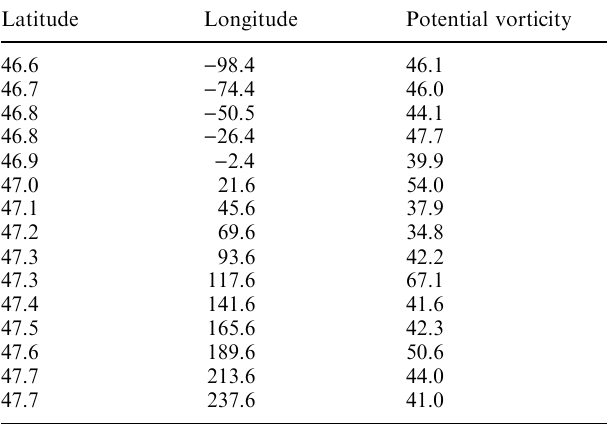
Table 4. Location and potential vorticity (in potential vorticity units, at 550 K potential temperature) of HALOE observations